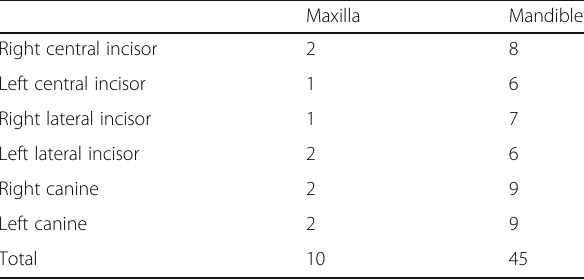
Table 1 Number and distribution of the 55 teeth of the sample